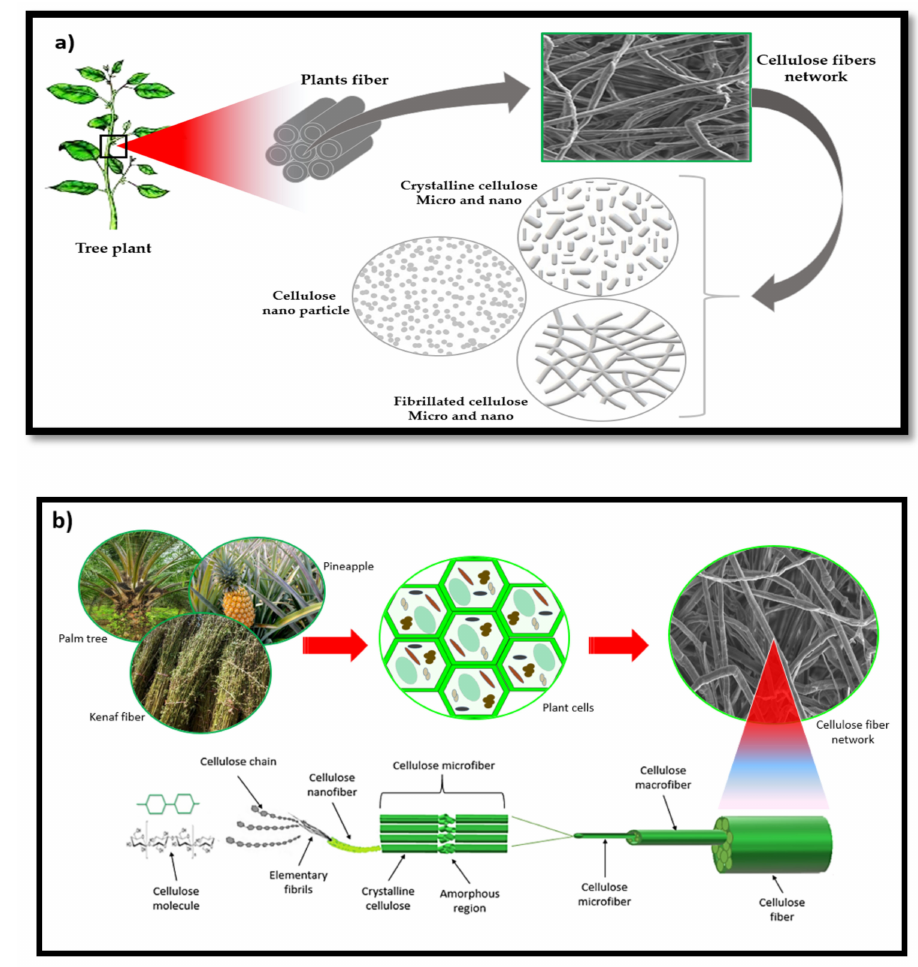
Figure 3. ( a ) Classification of nanocellulose materials based on microstructural forms. ( b ) Schematic diagram of di ff erent scientific forms and structure of cellulose